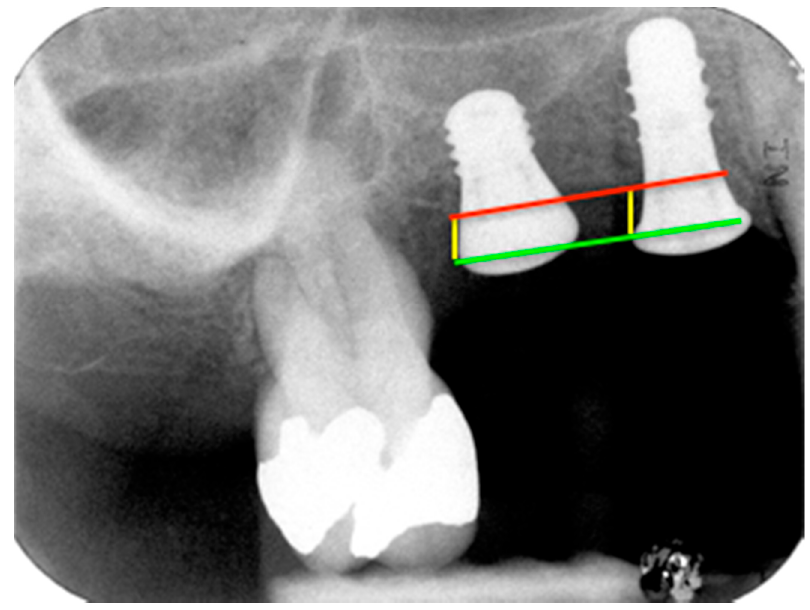
Figure 1. References for MBL and CBL measurements: CBL, red; implant shoulder (IS), green; implant shoulder to first point of bone-to-implant contact (IS-BIC), yellow.